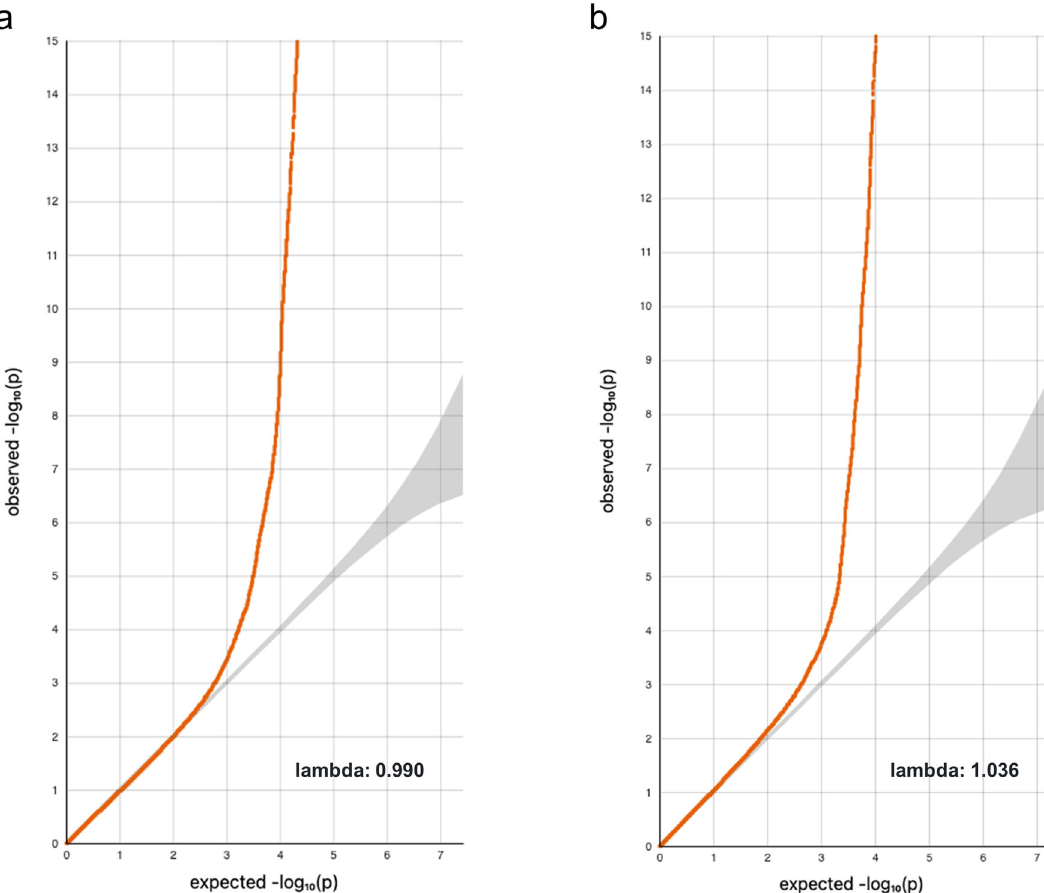
Fig. 2 QQ plots of the GWAS. a GWAS of GERA discovery cohort ( n = 63,110). b GWAS of meta-analysis combining GERA and MGB Biobank cohorts ( n = 92,240). Lambda indicates in fl ation factor. Table 3 Replication of previous AK GWAS results in the GERA discovery cohort and MGB Biobank cohort. SNP Chr Pos